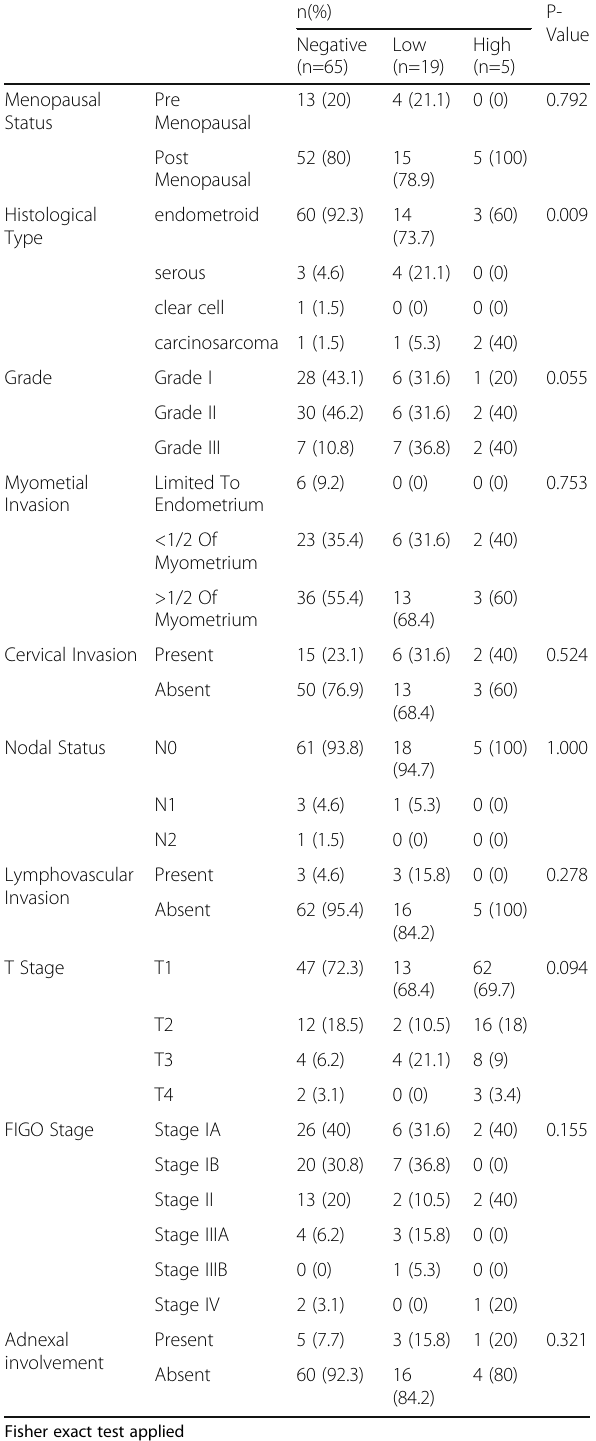
Table 2 Association of Epidermal growth factor receptor (EGFR) expression with clinico-pathologic parameters of Endometrial